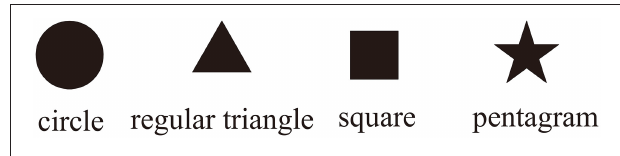
FIGURE 8 | Stimuli used in Experiment 4.